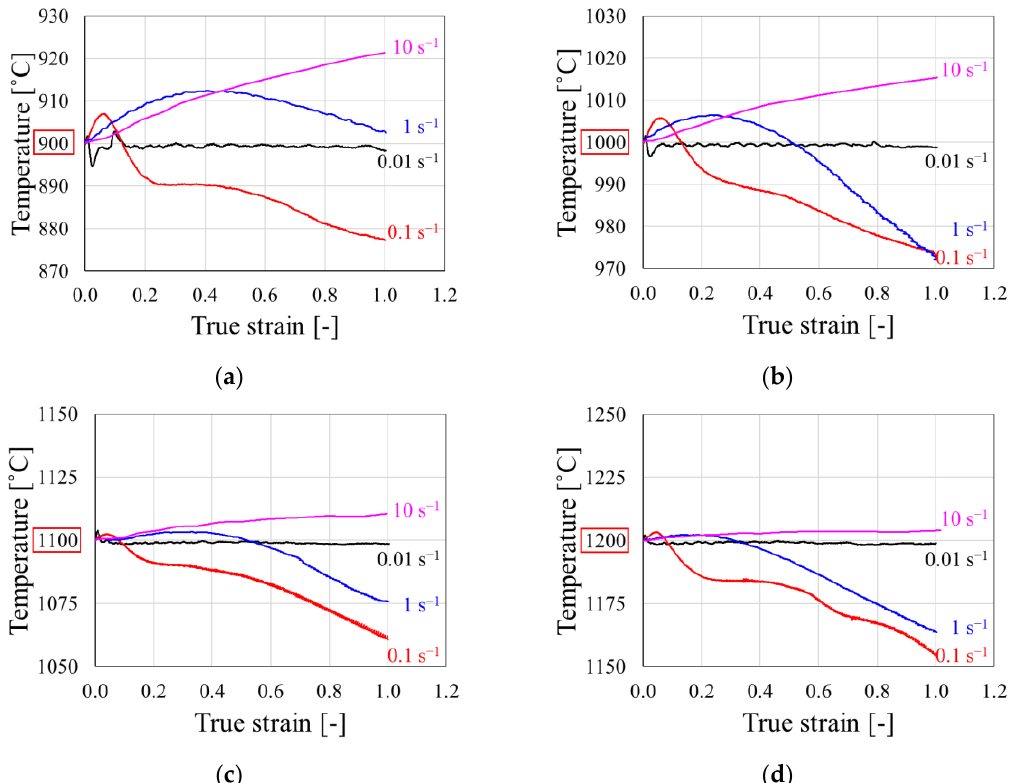
Figure 3. Temperature change of specimen during compression test: ( a ) 900 °C, ( b ) 1000 °C, ( c ) 1100 °C, ( d ) 1200 °C.